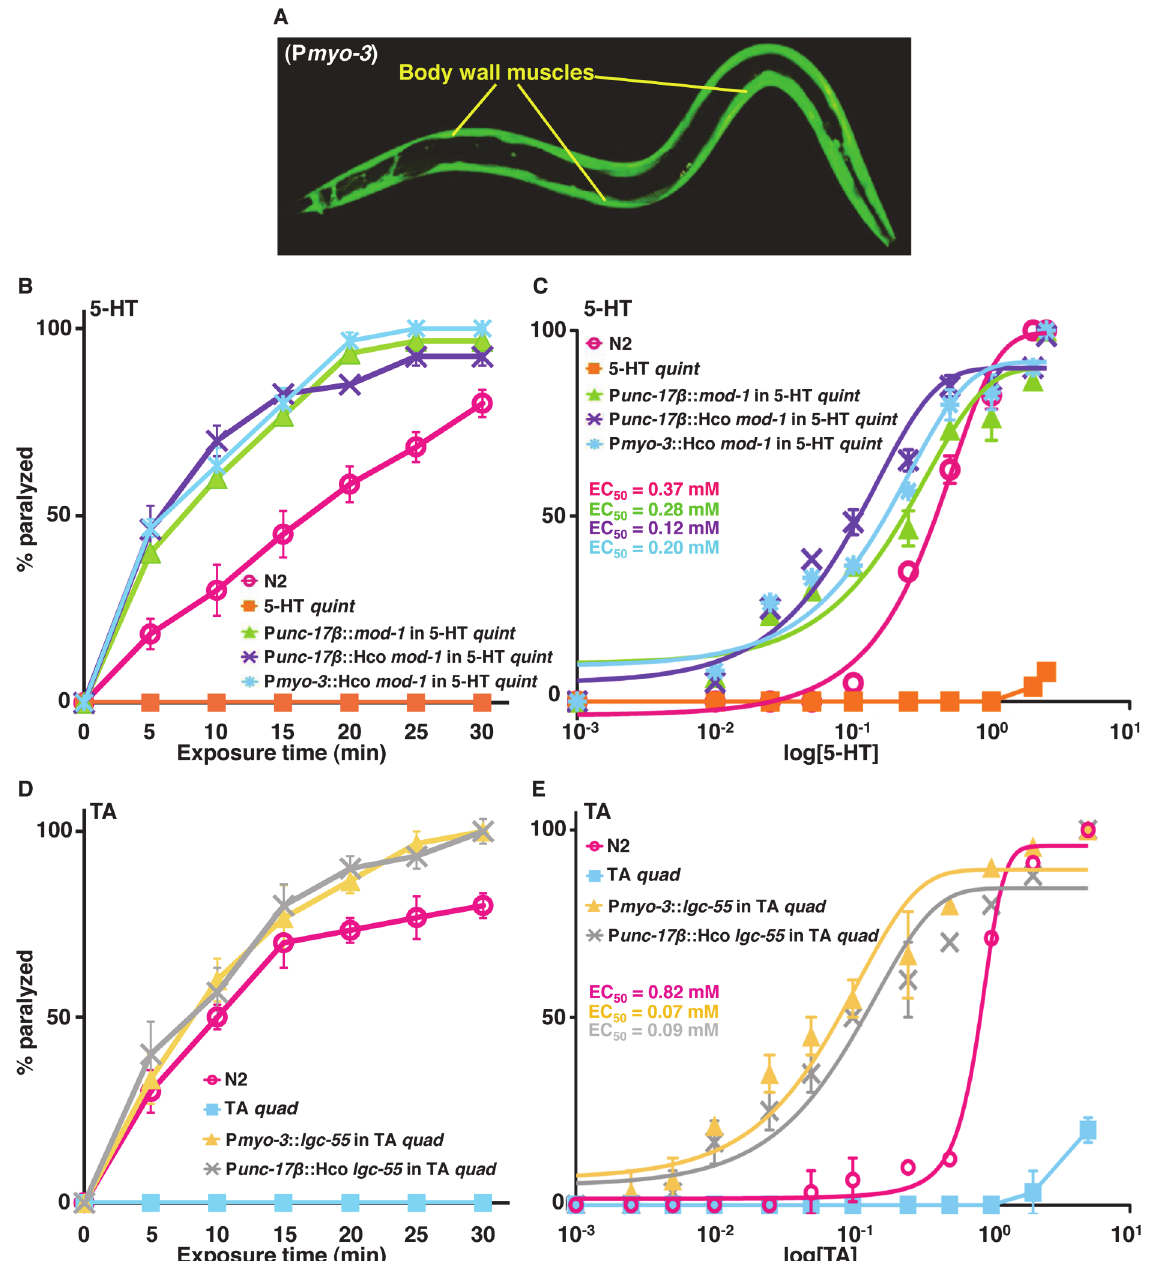
Fig 5. Exogenous monoamines paralyze C . elegans expressing monoamine-gated Cl - channels in either cholinergic motor neurons or body wall muscles. A. Confocal image of 5-HT quint animals expressing H . contortus (Hco) MOD-1::GFP in body wall muscles (P myo-3 ). GFP-fluorescence image. B-E. Paralysis of wild type, mutant and transgenic C . elegans on non-NGM agar plates. B. 5-HT (0.5 mM)-dependent paralysis of wild type, 5-HT quint and 5-HT quint animals expressing either the C . elegans or H . contortus (Hco) MOD-1 orthologues in the cholinergic motor neurons (P unc-17 β ) or the H . contortus (Hco) MOD-1 orthologue in body wall muscle (P myo-3 ). Data are presented as mean ± SE (n = 4). C. Dose-response curves for 5-HT-dependent paralysis at 15 min exposure for wild type, 5-HT quint and 5-HT quint animals expressing either the C . elegans or H . contortus (Hco) MOD-1 orthologues in the cholinergic motor neurons (P unc-17 β ) or the H . contortus (Hco) MOD-1 orthologue in body wall muscle (P myo-3 ). D. Tyramine (1 mM)-dependent paralysis of wild type, TA quad and TA quad animals expressing either the C . elegans LGG-55 in body wall muscle (P myo-3 ) or the H . contortus (Hco) LGC- 55 orthologue in the cholinergic motor neurons (P unc-17 β ). Data are presented as mean ± SE (n = 3). E. Dose-response curves for TA-dependent paralysis at 15 min exposure for wild type, TA quad and TA quad animals expressing either LGC-55 in the body wall muscles (P myo-3 ), or H . contortus (Hco) LGC-55 orthologue in cholinergic motor neurons (P unc-17 β